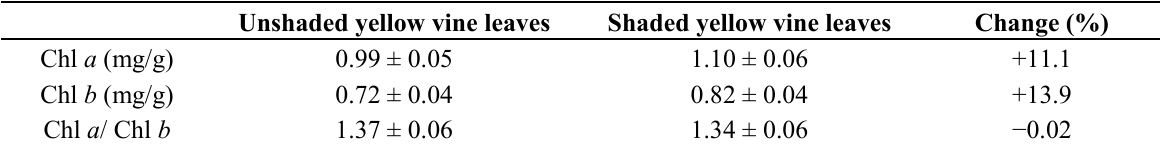
Table 1. Analytical results of Chl a , Chl b , and the Chl a /Chl b ratio in the methanol extracts of yellow vine samples in the absence and presence of shade